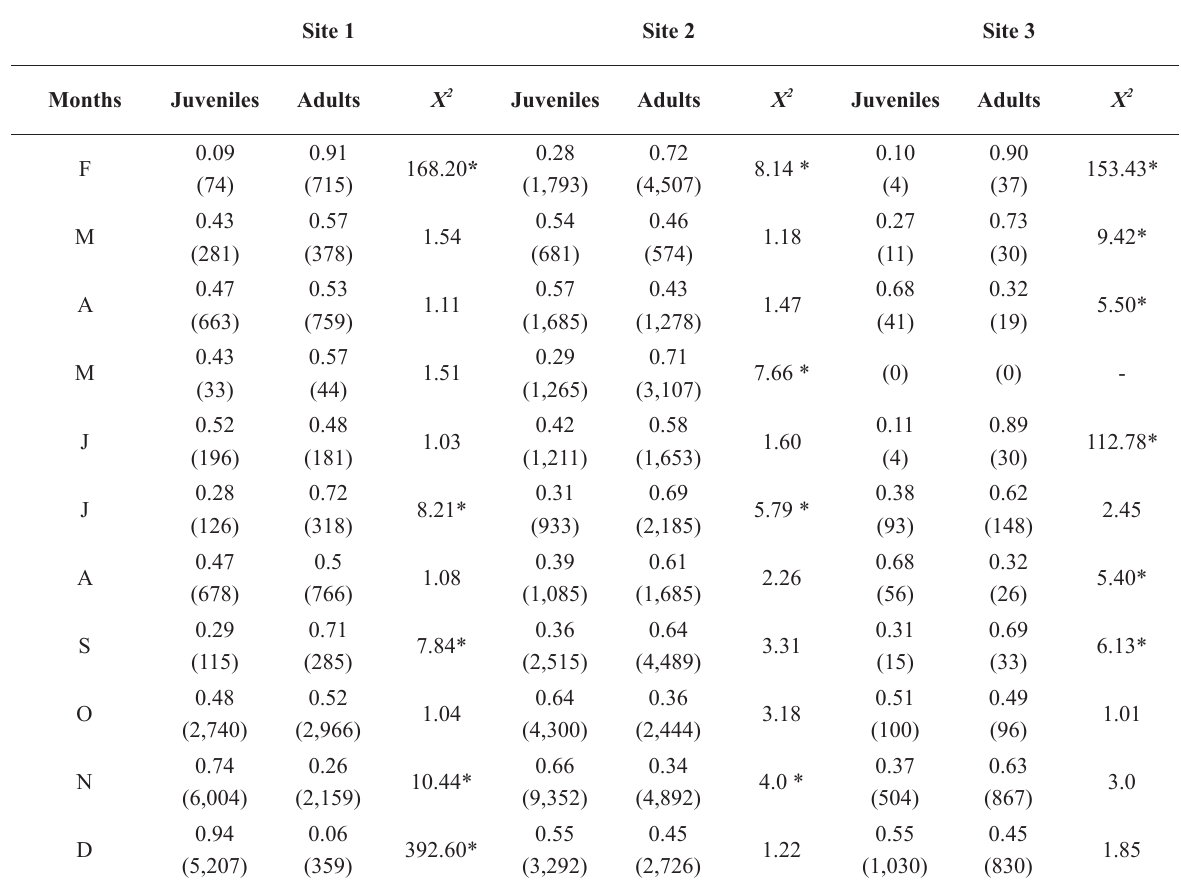
Monthly variation in the proportion of juveniles and adults of H. pampeana at each site with respective results of Chi squared test for goodness of fit ( X 2 ). Asterisks indicate significant differences in the proportion 1 adult: 1 juvenile (p<0.01). Density values (ind/m 2 ) of juveniles and adults are indicated in